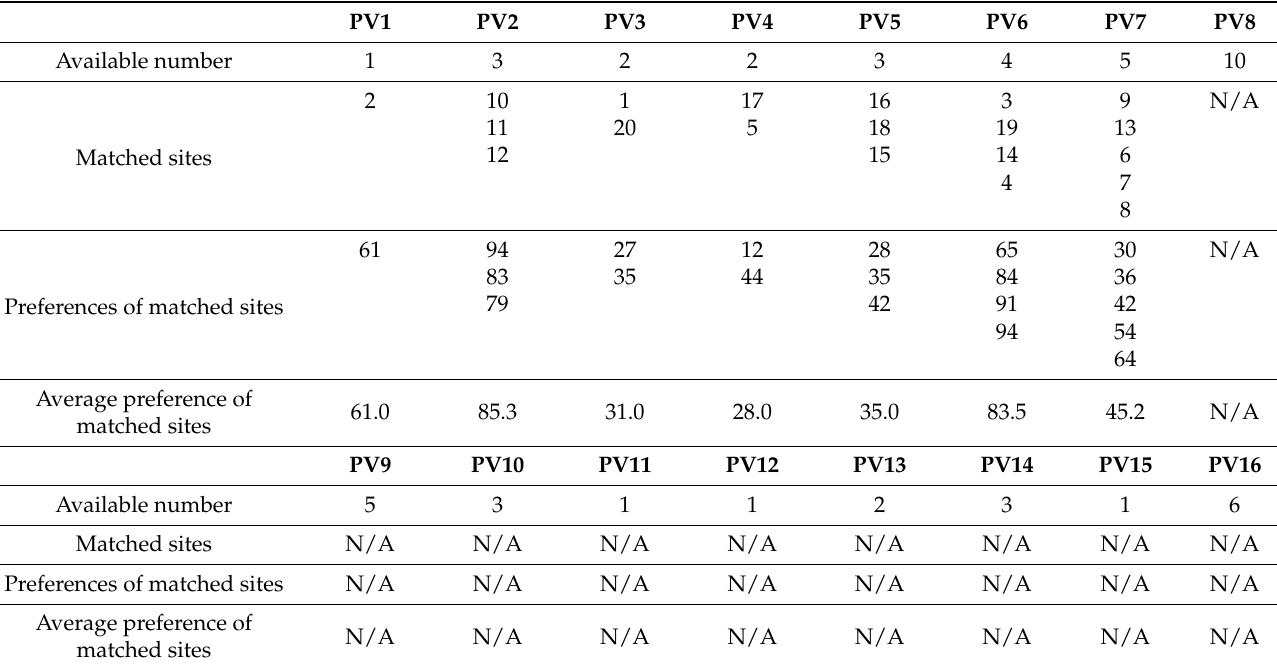
Table 7. Matching results for PV